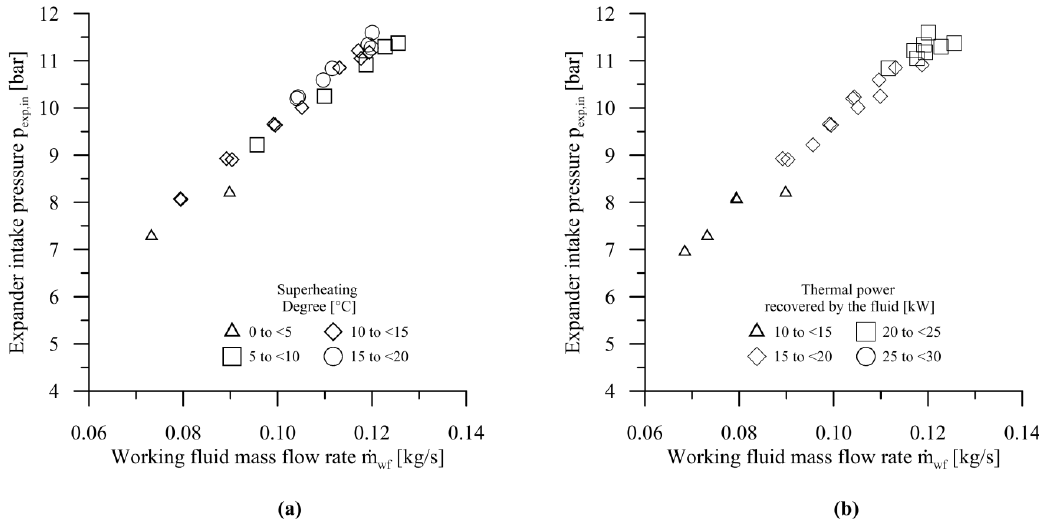
Figure 2. ( a ) Intake pressure varying the mass flow rate for different values of superheating degree; and ( b ) intake pressure varying the mass flow rate for different values of thermal power recovered.